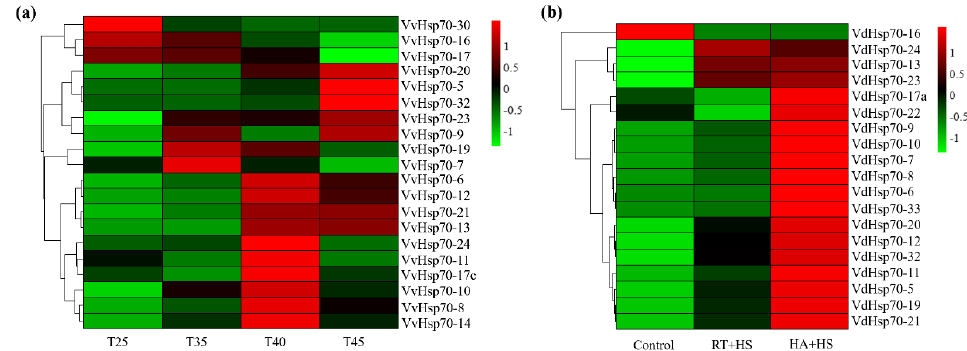
Figure 6. Expression analysis of grape Hsp70 genes in response to heat stress. ( a ) Expression analysis of VvHsp70 genes in response to heat stress. Transcription data came from our previous research [29]. Some VvHsp70 genes were not shown as their expression was not detected. T25, T35, T40, and T45 mean the expression of VvHsp70 genes after 25, 35, 40, and 45 ◦ C for 2 h. The color scale represents relative expression level. ( b ) Expression analysis of VdHsp70 genes in response to heat stress by qRT-PCR. V. davidii grape leaves treated with (1): 25 ◦ C 2 h and 40 min, (2): 25 ◦ C 2 h and 47 ◦ C 40 min, and (3): 38 ◦ C 2 h and 47 ◦ C 40 min were marked as Control, RT + HS, and HA + HS, respectively.